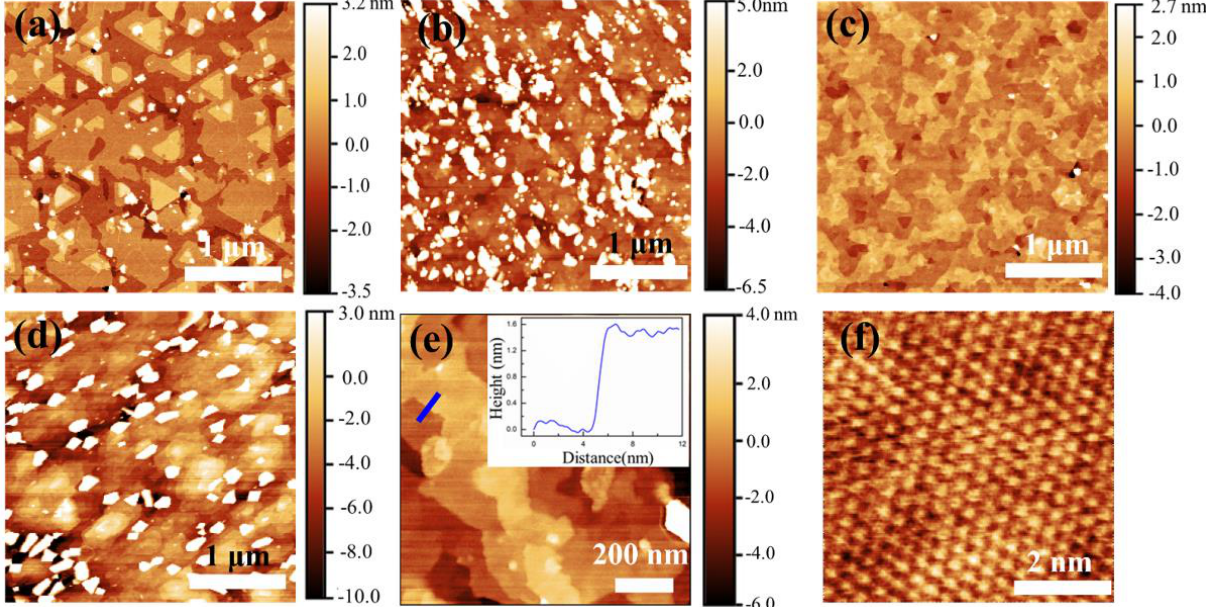
Figure 2. The dependence of film morphology on T G and ϕ r from an AFM: ( a ) Bi 2 Te 3 surface (3 µ m × 3 µ m). ( b ) ϕ r = 0.09 and T G = 310 ◦ C (3 µ m × 3 µ m); ( c ) ϕ r = 0.09 and T G = 410 ◦ C (3 µ m × 3 µ m); ( d ) ϕ r = 0.5 and T G = 430 ◦ C (3 µ m × 3 µ m); ( e ) Magnified AFM image of ( c ); the inset is a height profile along the blue solid line marked in ( e ), showing a step size of 1.4 nm. ( f ) Atom-resolved STM image of ( c ), showing Te-terminated hexagonal atomic structure (size: 6 nm × 6 nm, sample bias: 0.5 V, tunnel current: 0.2 nA).